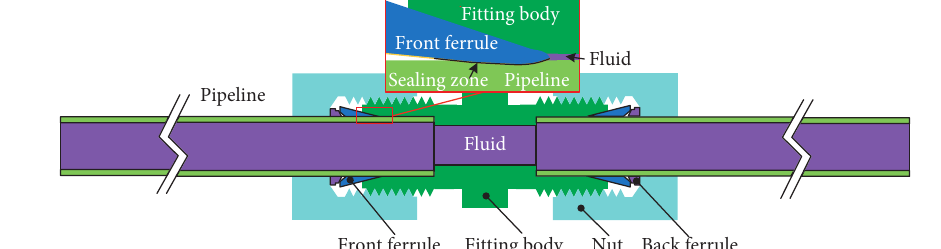
Figure 1: Structure of pipeline fittings.